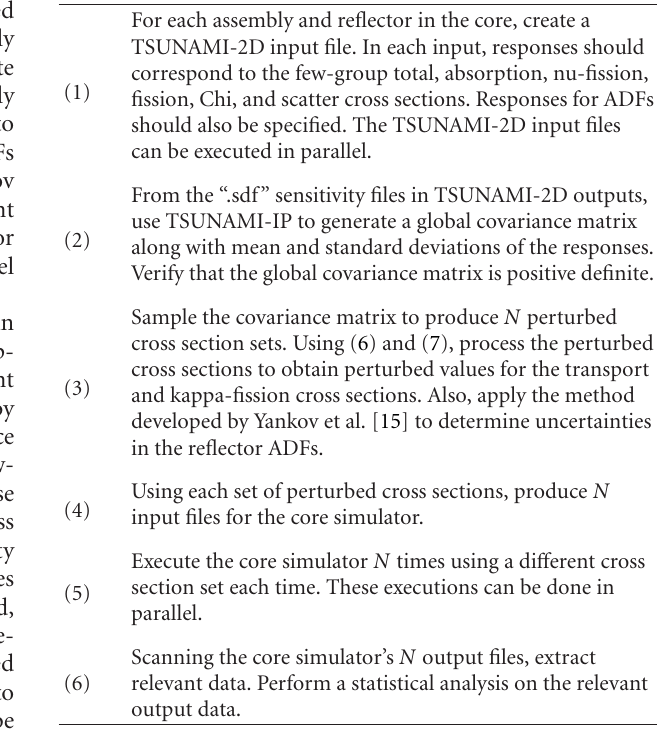
Table 1: Algorithm for applying the two-step method using SCALE and a core